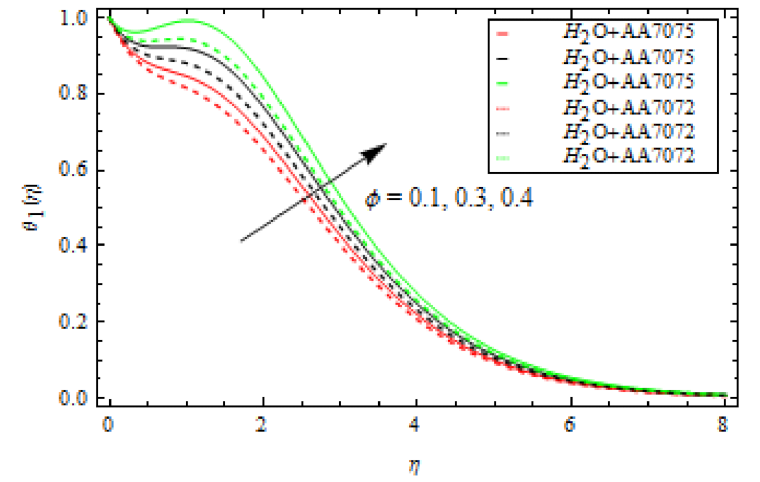
Figure 12. Influence of volume fraction φ on temperature